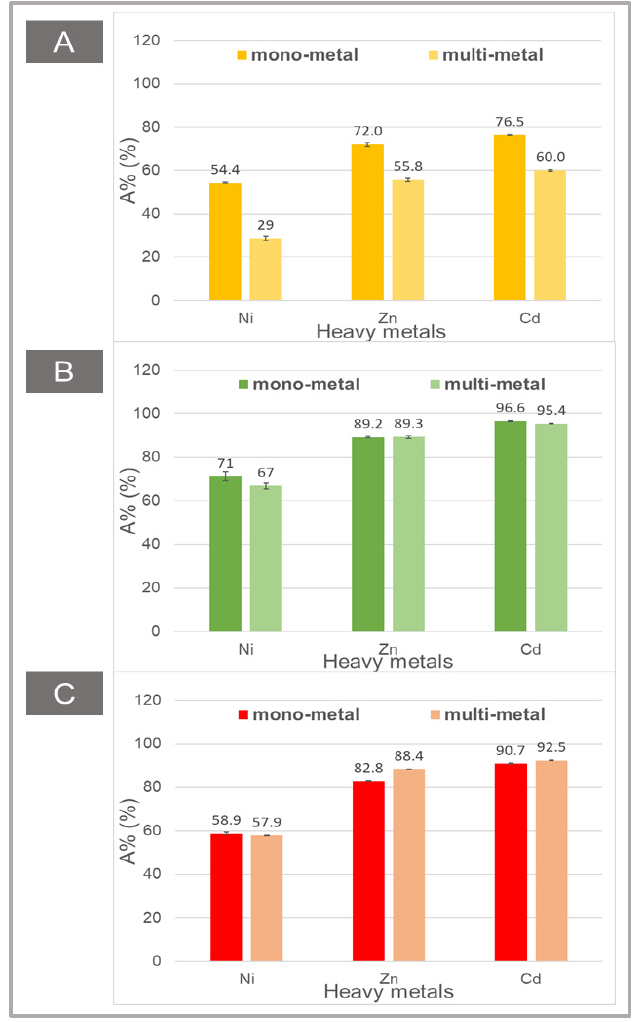
Figure 10. Comparison of the adsorption percentage (A%) of Ni(II), Zn(II) and Cd(II) in mono-metal and multi-metal solutions on: ( A ) pine sawdust, ( B ) sunflower seed hulls, ( C ) corn residues mix.